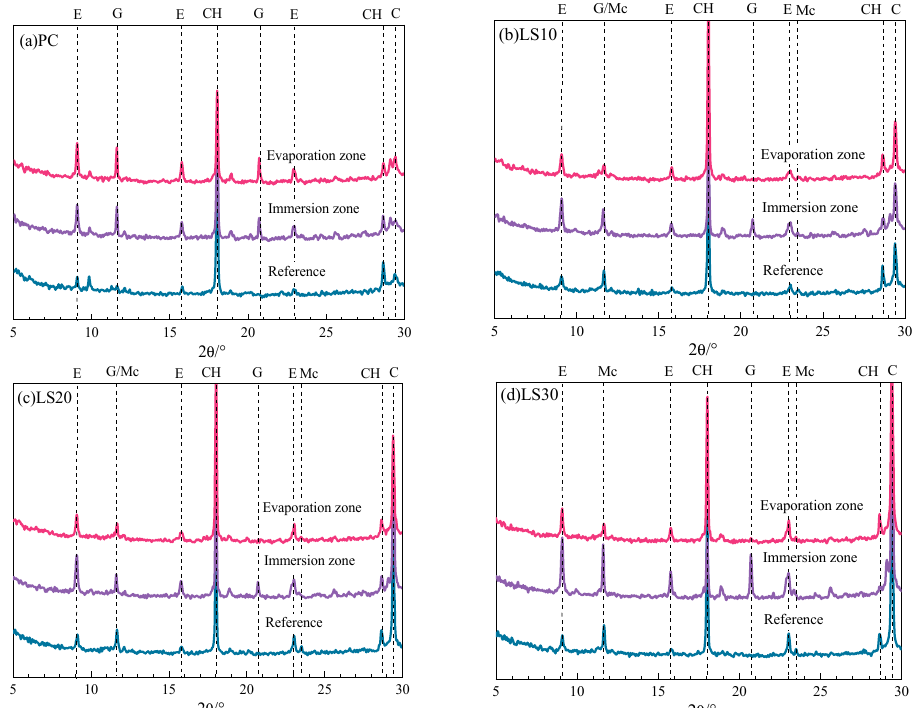
Figure 6. XRD pattern of specimens with different limestone content after partially immersed spec- imens for 50 days. (E—ettringite; G—gypsum; Mc—monocarboaluminate; CH—portlandite). specimens for 50 days. (E—ettringite; G—gypsum; Mc—monocarboaluminate;